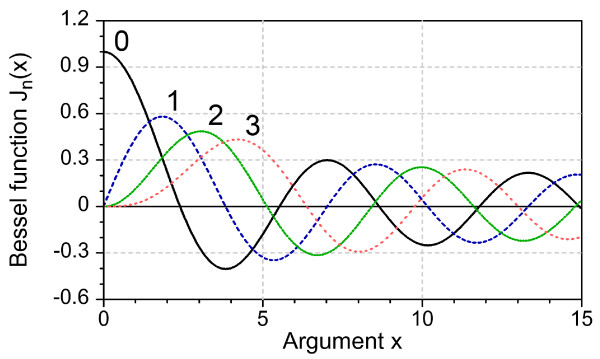
Cylindrical Bessel functionsJn(x). Curve numbers correspond to order n.